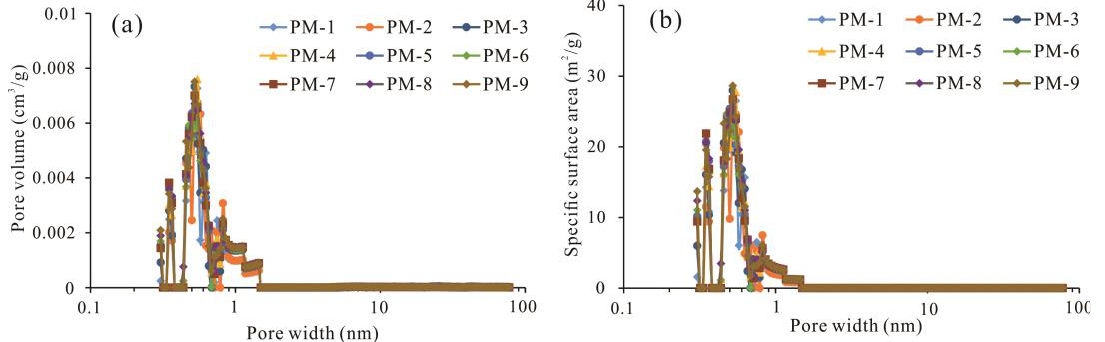
Figure 11. PV and SSA rates of change for all the pore sizes by using two models: ( a ) pore volume, ( b ) specific surface area. Table 6. The PV, SSA and proportions of micro, meso-, and macropores in different coals. PV (cm 3 Samples